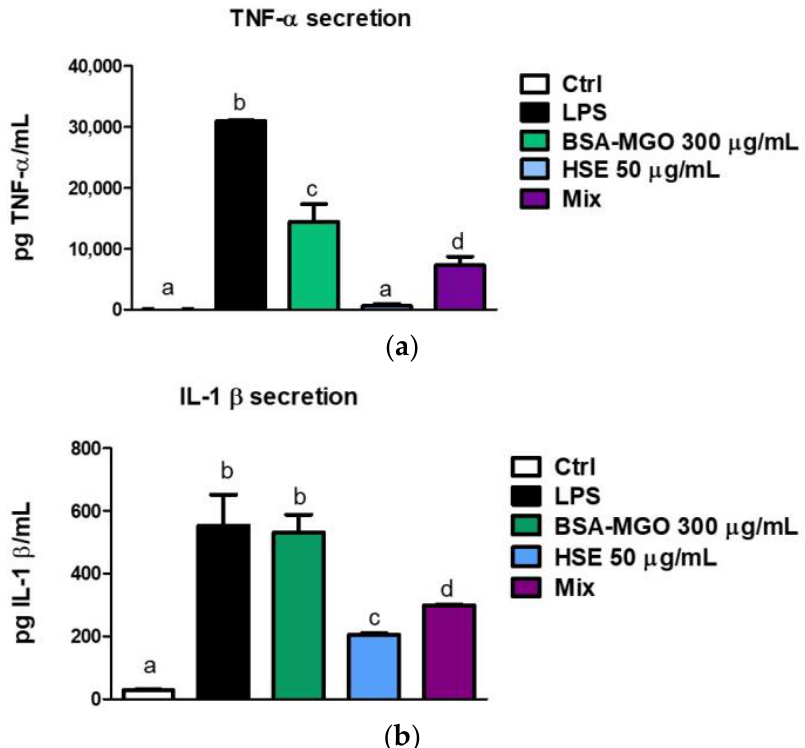
Figure 8. Quantification of pro-inflammatory cytokines TNF- α and IL-1 β . THP-1 macrophages (M0) were treated with BSA-MGO, HSE or in combination (MIX). Levels of ( a ) TNF- α and ( b ) IL-1 β secreted proteins were determined by ELISA assay, after 24 h. Data were expressed as pg standard/mL. All data represent the means ± SD of two independent experiments. The analysis of variance was carried out using one-way ANOVA followed by the Tukey’s multiple comparison test: letters denote significant differences among samples. p < 0.01 BSA–MGO vs. MIX for TNF- α ; p < 0.05 BSA–MGO vs. MIX for IL-1 β).